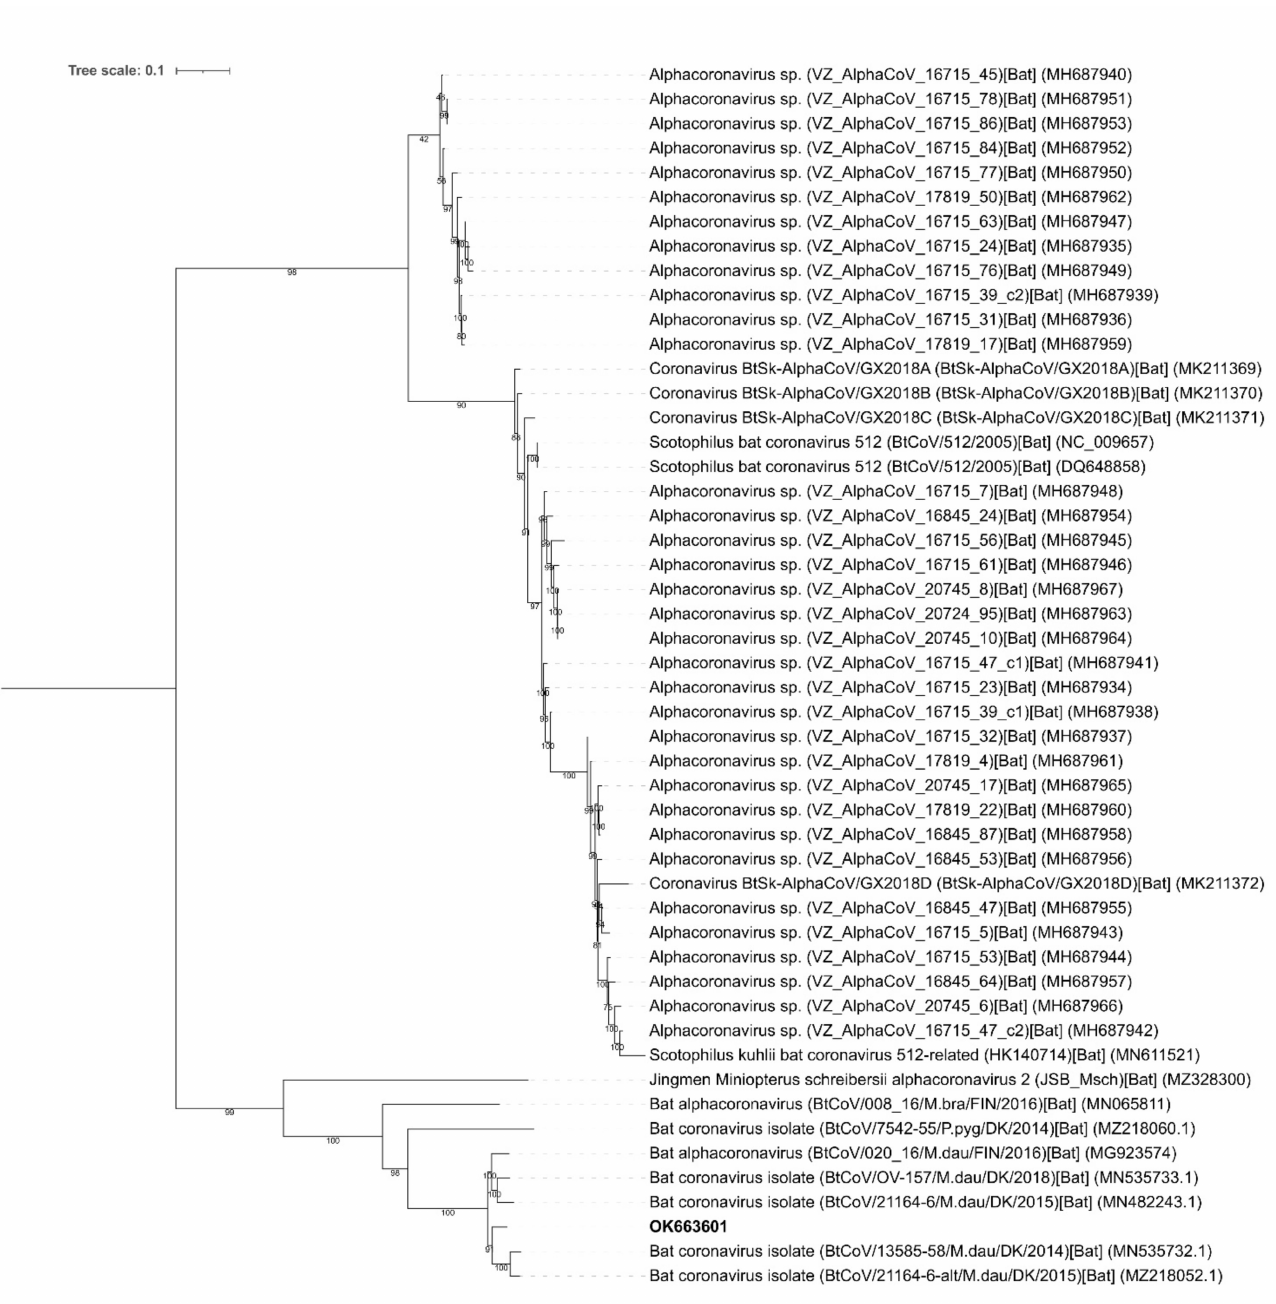
Figure 3. Phylogenetic relationships between the nucleotide sequence of the alpha-CoV detected in the study (OK663601 in bold) and 52 other strains. The Middle East respiratory syndrome coronavirus (MERS-CoV) (KJ713299.1) was used as an outgroup (Figure